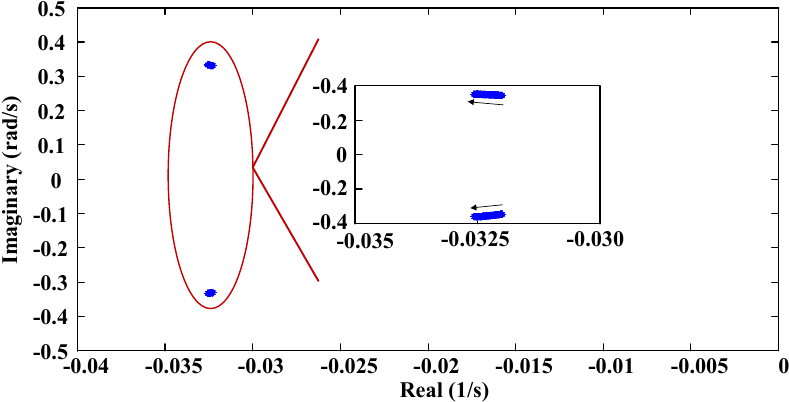
Figure 12. Participation factors. The state variables are the same as in Figure 9.